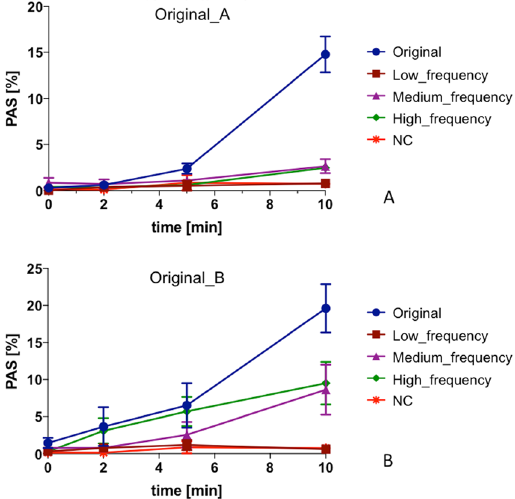
Figure 4. Experimental dynamics of SMPA (PAS values over time) of HSD-stimulated platelets as measured through the PAS assay; ( A ) Original_A; ( B )